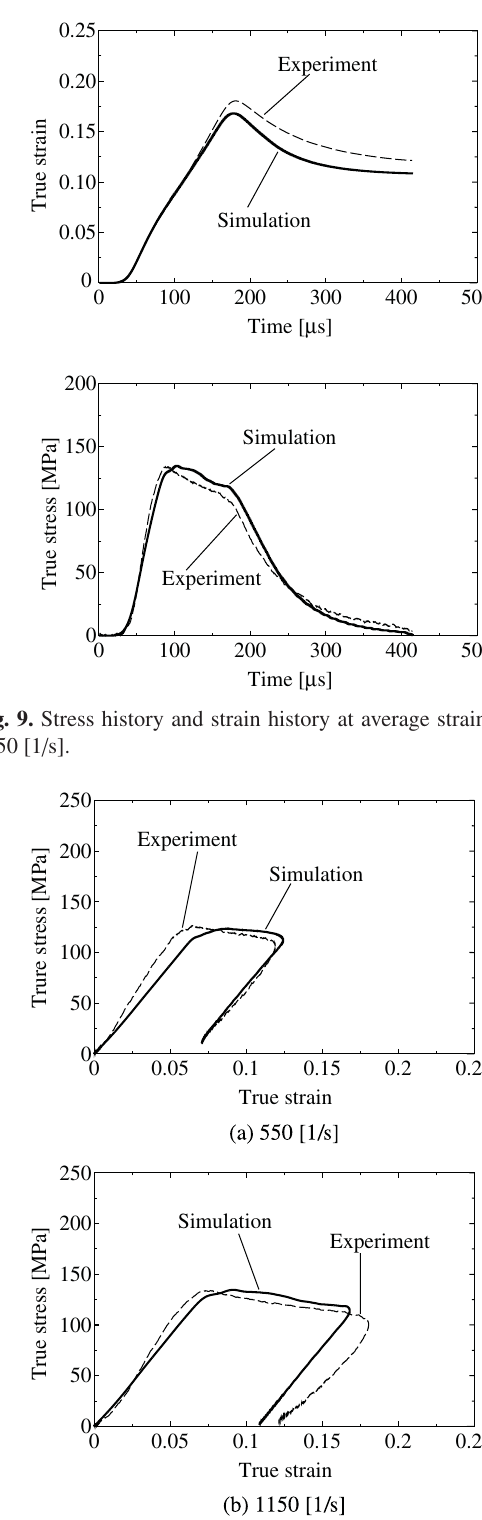
Fig. 10. Comparison of stress-strain curves between simulation and experiment.